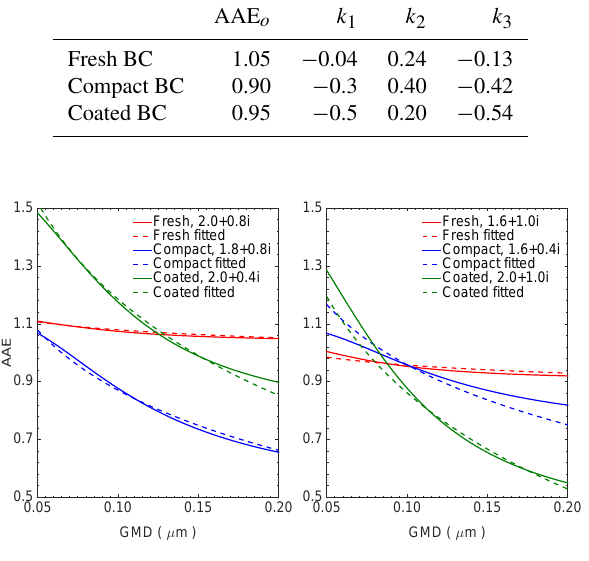
Figure 9. Comparison between the AAEs given by accurate numer- ical simulations (solid curves) and those approximated by Eq. (6) and the corresponding coefficients in Table 2 (dashed